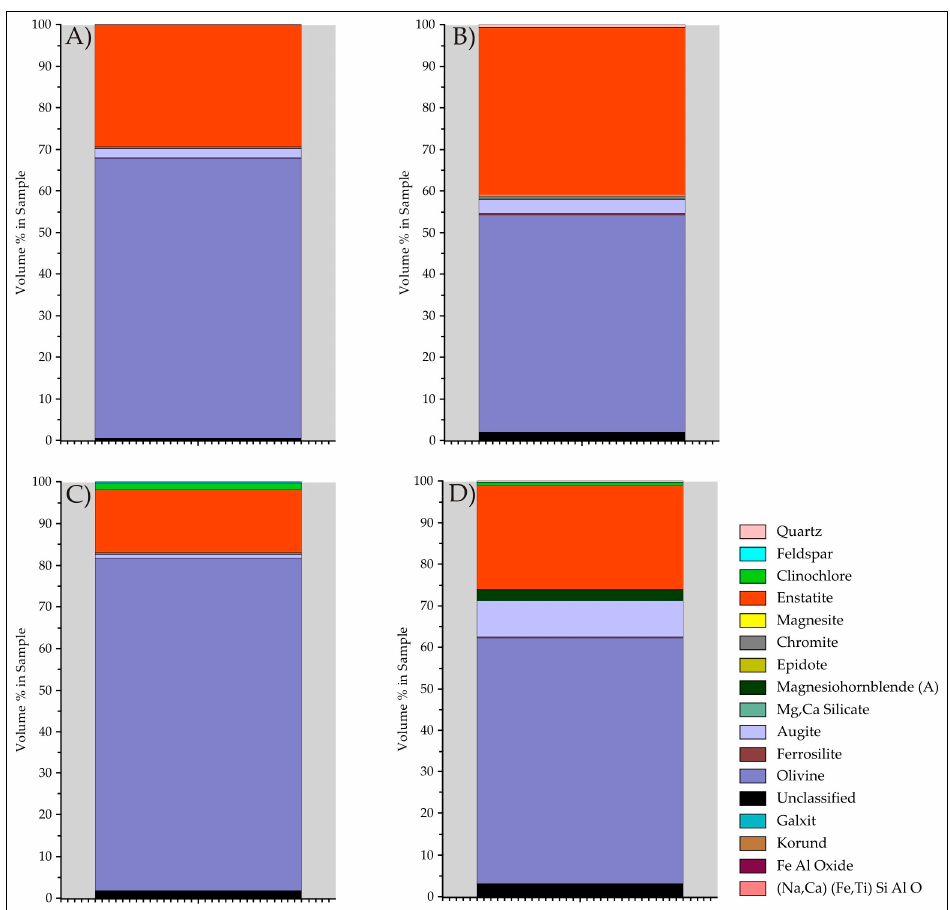
Figure 6. Quantitative Modal determination by QEMSCAN ® ( A ) Thermolith ( B ) Grecian Magnesite ( C ) Steinsvik ( D ) Nuova Cives. Table 4. Quantitative analysis by QEMSCAN ® of four different samples of olivine bearing rocks from Europe.